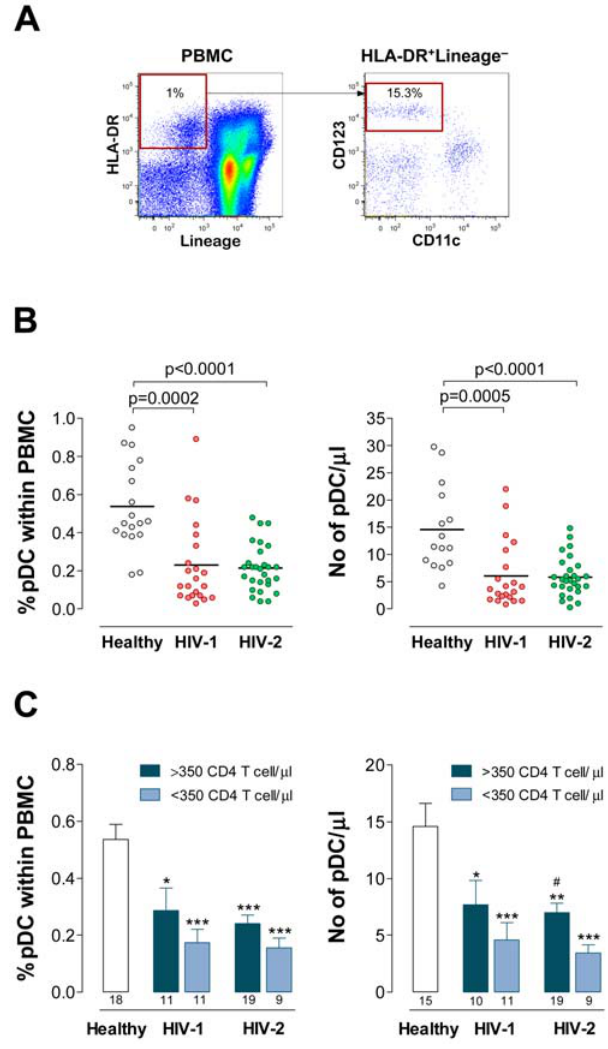
Figure 1. Similar reduction of circulating pDC in HIV-1 and HIV- 2 infections. A representative flow cytometric pDC analysis is shown in ( A ). After a large gate including lymphocytes and monocytes defined by forward and side scatter, cells were further gated on HLA-DR + cells that do not express lineage markers (left dot-plot). pDC were subsequently identified as CD123 + CD11c 2 cells (right dot-plot). Numbers represent the percentage of cells within the illustrated gates from an HIV-2 infected patient with 523 CD4 T cell/ m l and undetectable viremia. The proportion of pDC within PBMC is 0.15% corresponding to 4 pDC/ m l. ( B ) Graphs show circulating pDC levels in HIV-1 and HIV-2 infected cohorts and healthy controls expressed as percentage within PBMC and absolute numbers. Each dot represents one individual and bars represent mean. ( C ) The infected cohorts were stratified according to CD4 T cell counts ( . 350 and , 350 cells/ m l) and pDC levels compared as percentages and absolute numbers. Bars represent mean 6 SEM. Numbers under the bars represent the total individuals analyzed. * p , 0.05, ** p , 0.01 and *** p , 0.001 as compared to pDC levels in controls. # p , 0.05 between early and advanced HIV-2